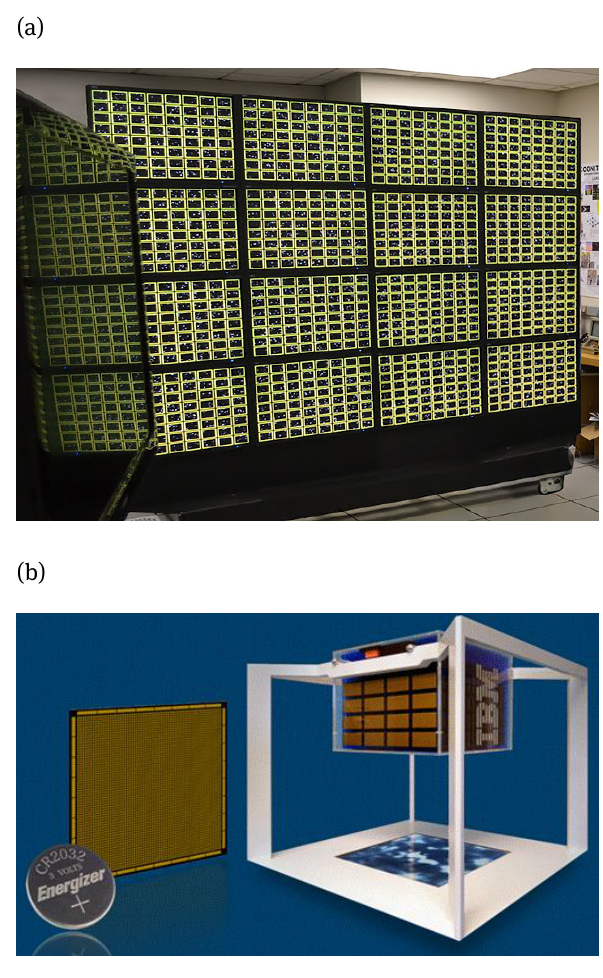
Figure 4: The Brain Wall and Brain Cube. (a) The brain wall is a neu- ral network visualization tool built by SyNAPSE project researchers at IBM; (b) The brain cube will have 256 million neurons, and 64 million synapses.